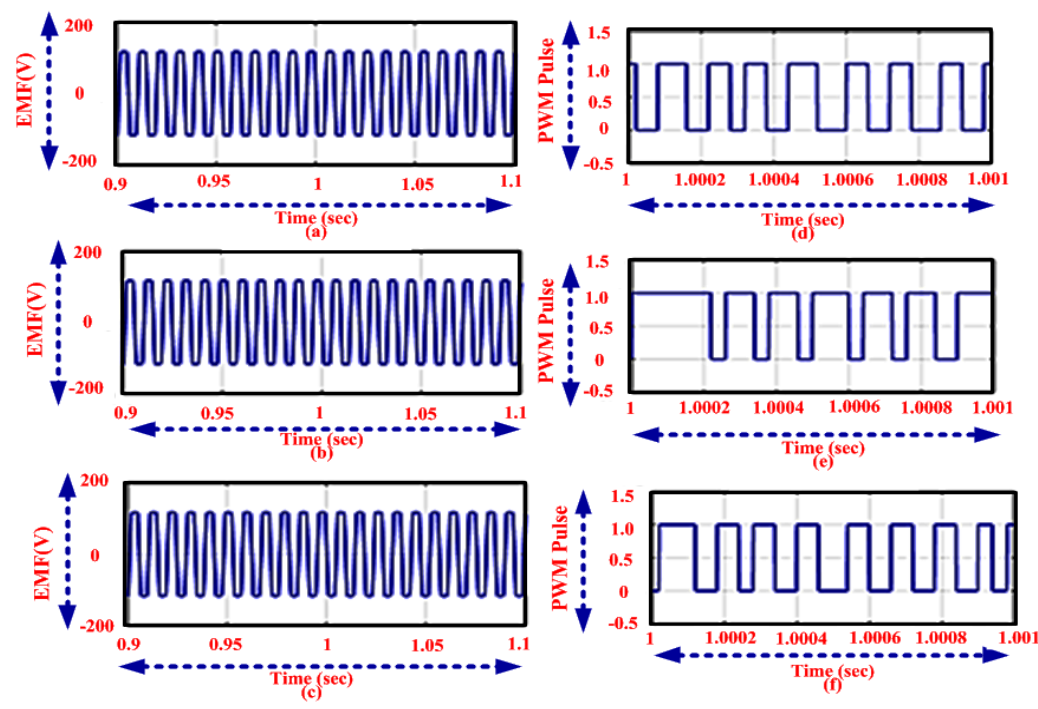
Figure 13. Analysis of EMF using the ( a ) proposed ( b ) MFO method and ( c ) PI controller and PWM using the ( d ) proposed ( e ) MFO method and ( f ) PI controller.